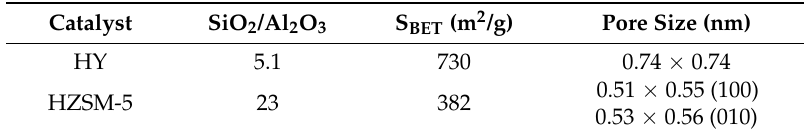
Figure 3. The temperature programmed desorption of ammonia (NH 3 -TPD) curves of HY and HZSM-5 used in this study. Table 2. Brunauer, Emmett and Teller (BET) surface area and pore size of HY and HZSM-5 used in this study.